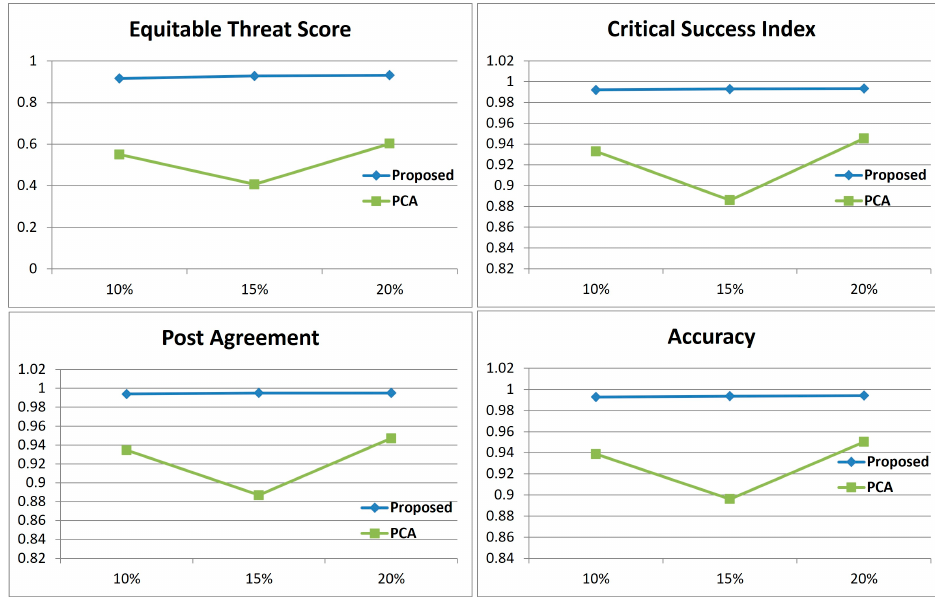
Figure 11. ETS/CSI/PAG/ACC result in binary: Proposed vs. PCA.